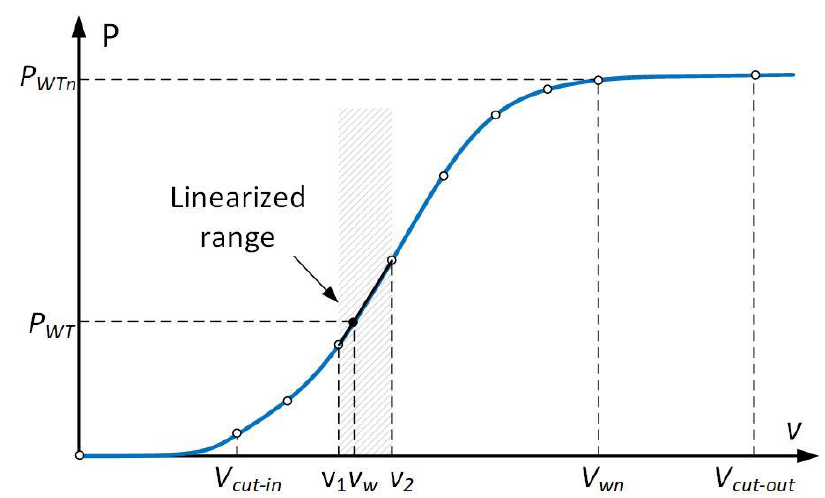
Figure 4. Graphical interpretation of determining method for P WT output power of a wind turbine in accordance with Relation (1).